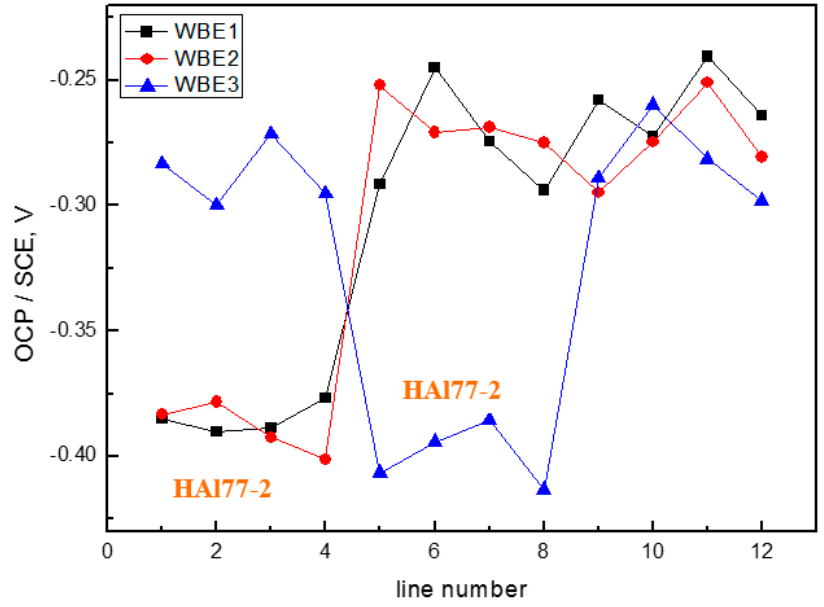
Figure 20. Average OCP distribution of each microelectrode line for the three electrodes after immersion in artificial seawater with 2.7 wt % Cl − at 70 °C.